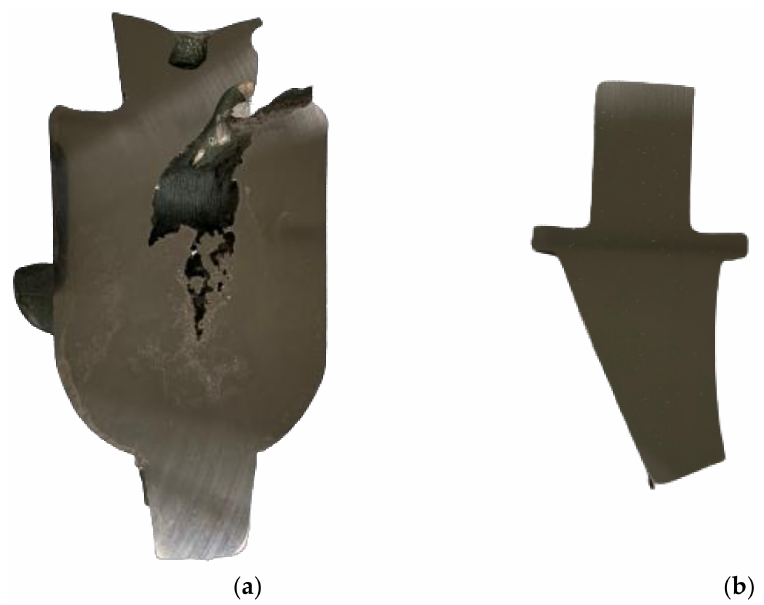
Figure 24. Shrinkage porosity of hip prostheses model. ( a ) Gating system and ( b ) hip prosthesis cross section